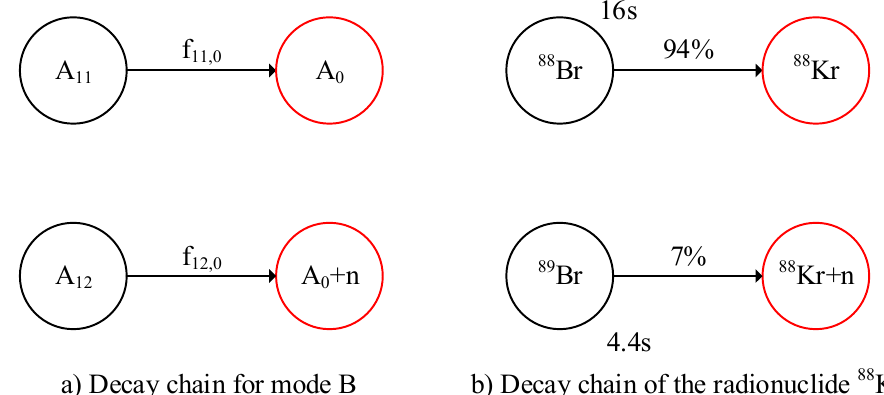
Figure 4. Sub-modes of General Mode A for the decay chain of the fission gas nuclide.